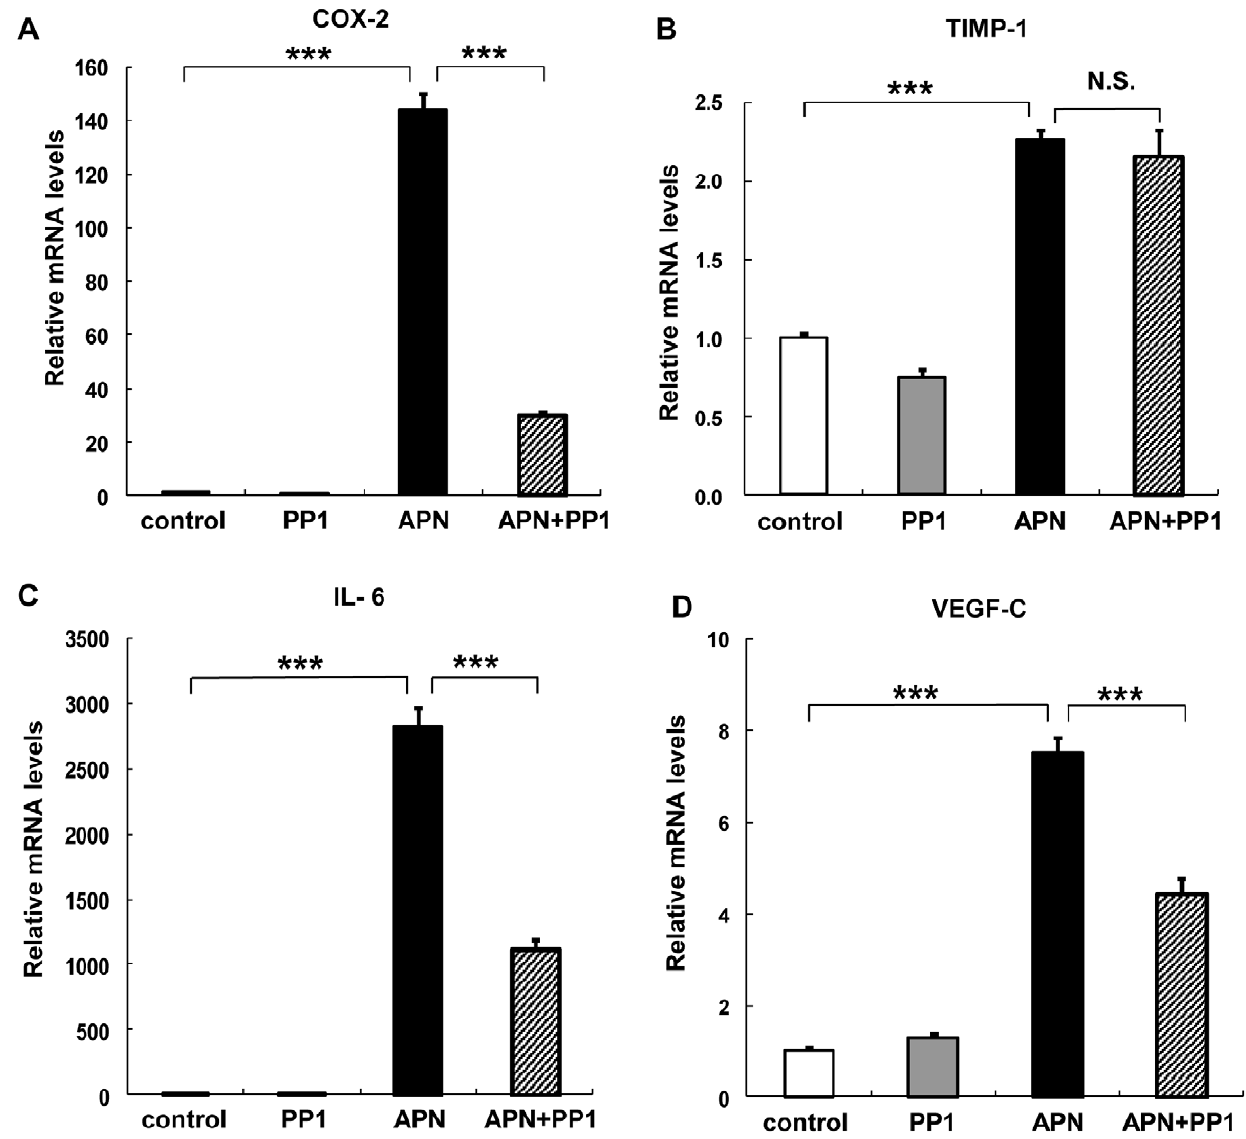
Figure 4. Effects of Src inhibitor on adiponectin-induced changes in peripheral blood monocyte-derived macrophages (PBDMs). PBDMs were preincubated with 10 m M PP1 for 30 min and then incubated with adiponectin for 6 hours (A–D). The mRNA expression levels of COX-2 (A), TIMP-1 (B), IL-6 (C), and VEGF-C (D) were quantified by real-time PCR. Values are normalized to the level of GAPDH mRNA and expressed as mean 6 SEM (n=3). ***P , 0.001. N.S not significant.